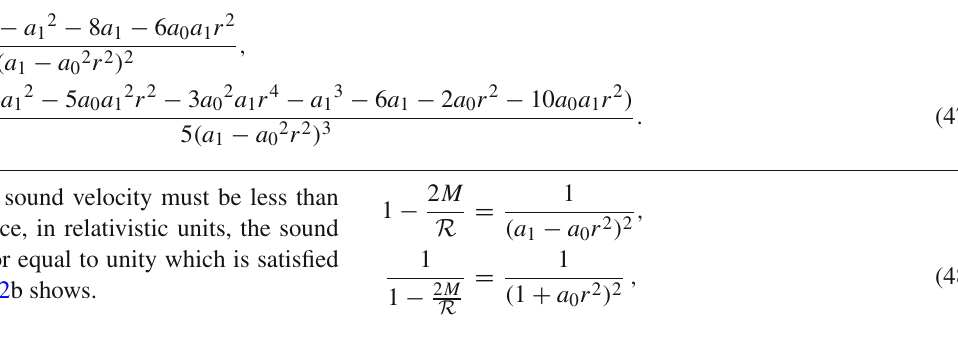
tangential pressures of Eq. (42) against radial coordinate